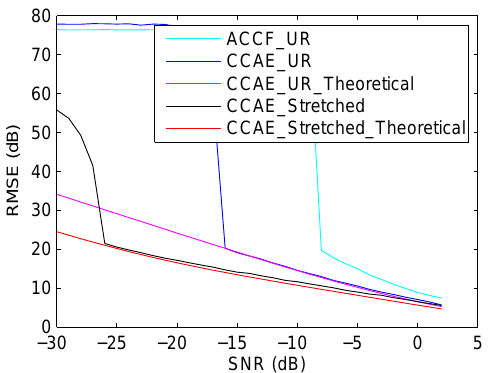
Figure 7. RMSE comparison of acceleration estimation by using CCAE on stretched signals, CCAE on UR signals and ACCF on UR signals (with acceleration).